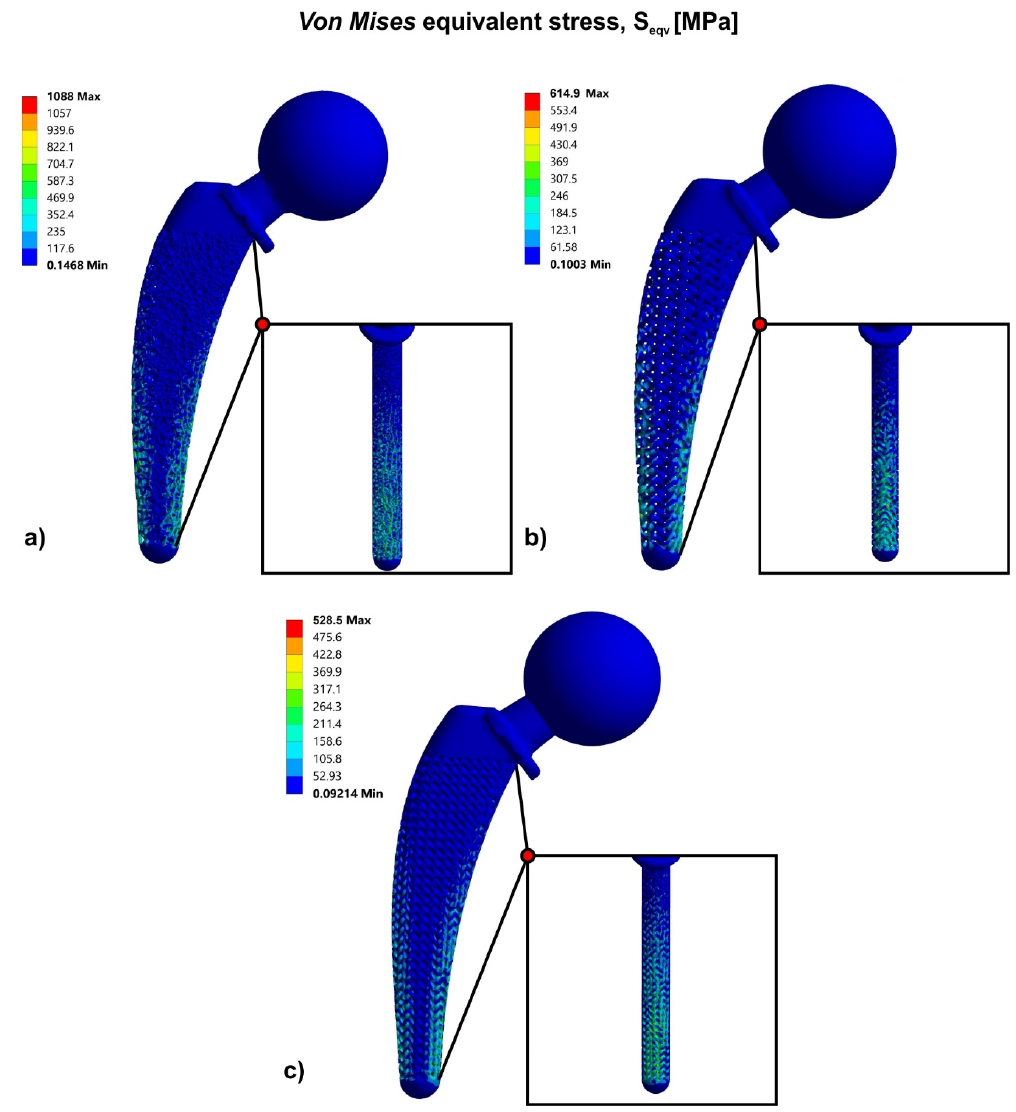
Figure 10. Von Mises stress contours of functionally graded hip implant with: ( a ) Voronoi structure; ( b ) Gyroid structure; ( c ) Schwarz Diamond structure.